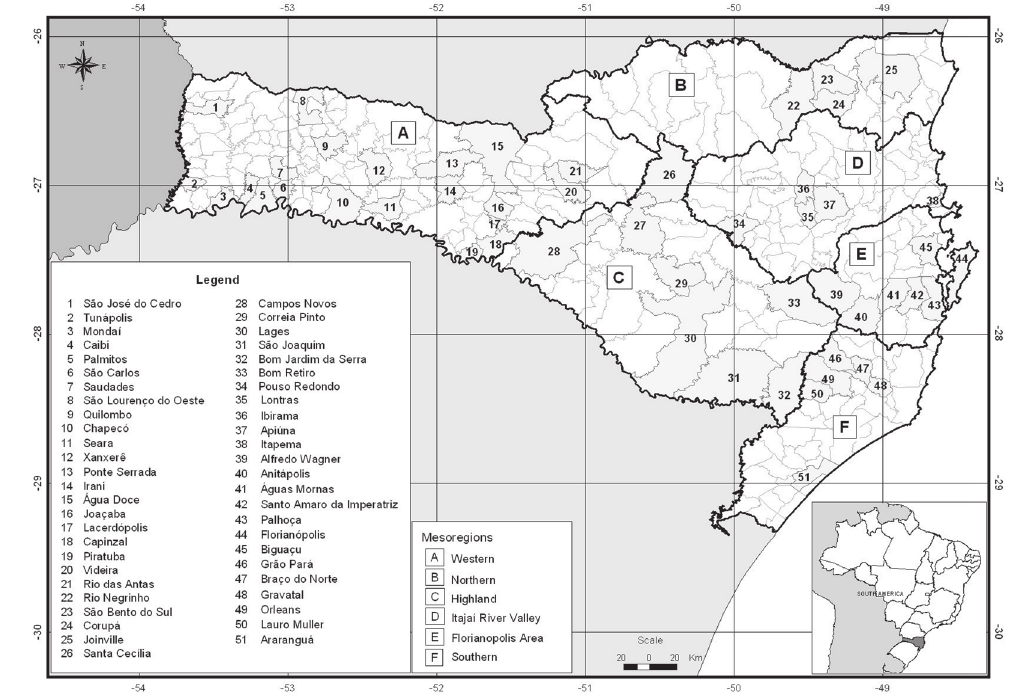
Figure 1. Santa Catarina municipalities where Simuliidae have been recorded, grouped by